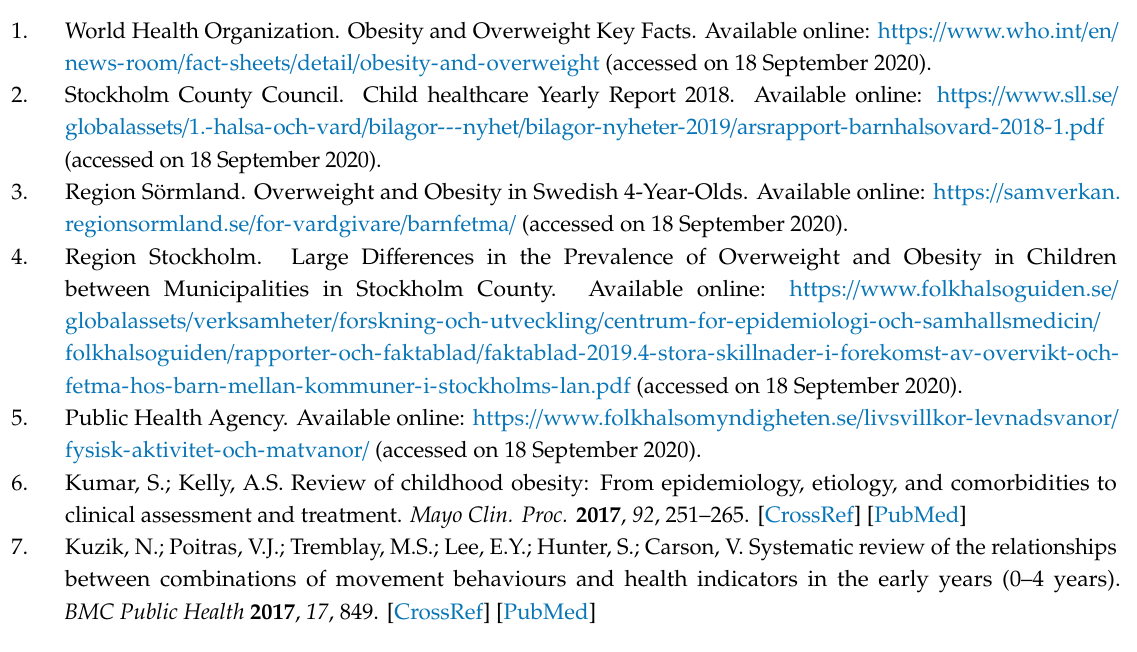
Table S1: Number and percentage of children being able to perform the gross and fine motor skills